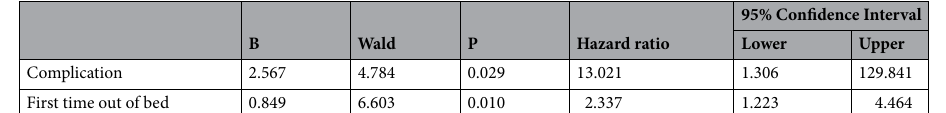
B Wald P Hazard